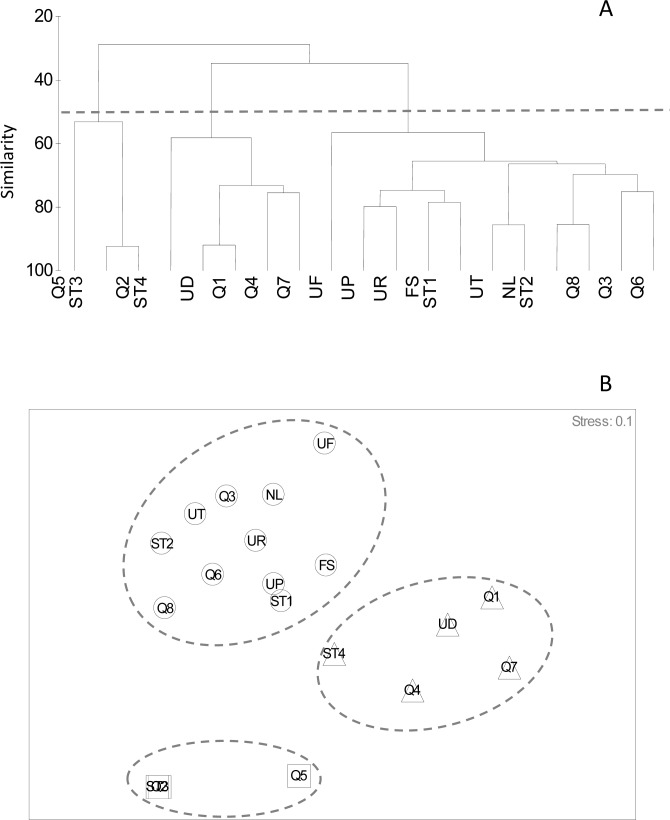
Cluster dendogram (a) and nMDS graph (b) of sampling stations based on crab species composition.Sampling sites were divided into the three groups at level of 50% bray-Curtis similarity. Triangle (Δ) = U. paradussumieri dominant sites, Square (□) = sandy sites, Circles (○) = station where U. rosea and U. triangularis are common.